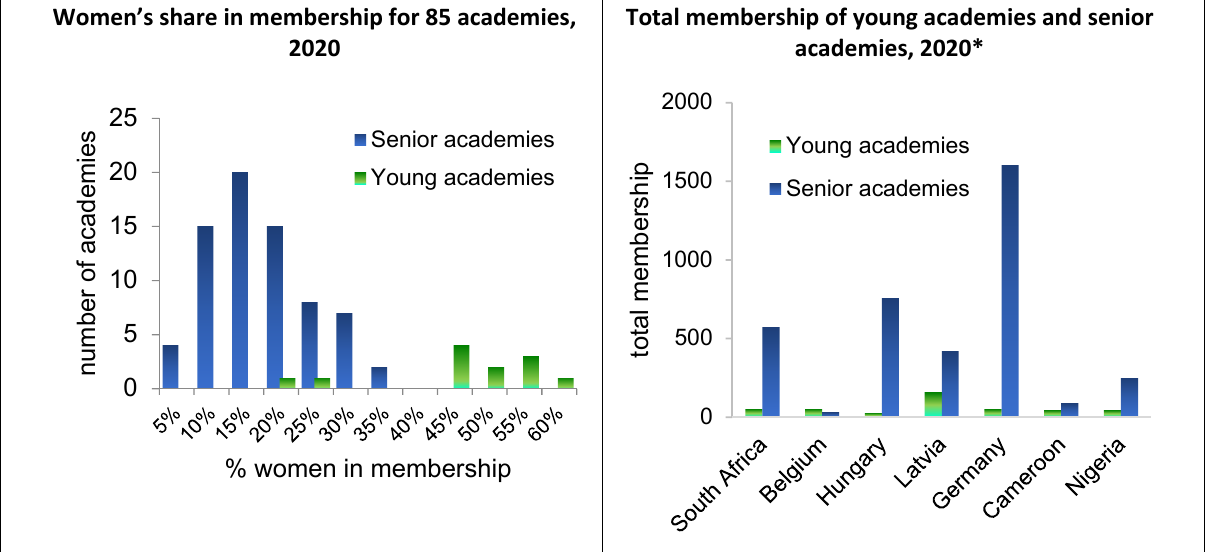
*Some countries host more than one senior academy; only one for each country is used for illustration here. Data source: ‘Results of two global surveys’ 1 . Can young academies change the